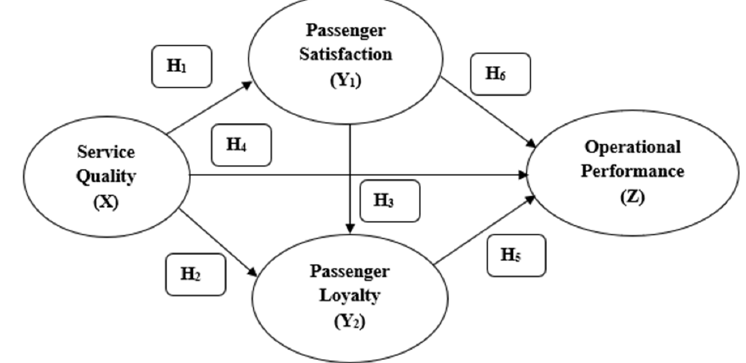
Fig. 1. Research Variable Constellation